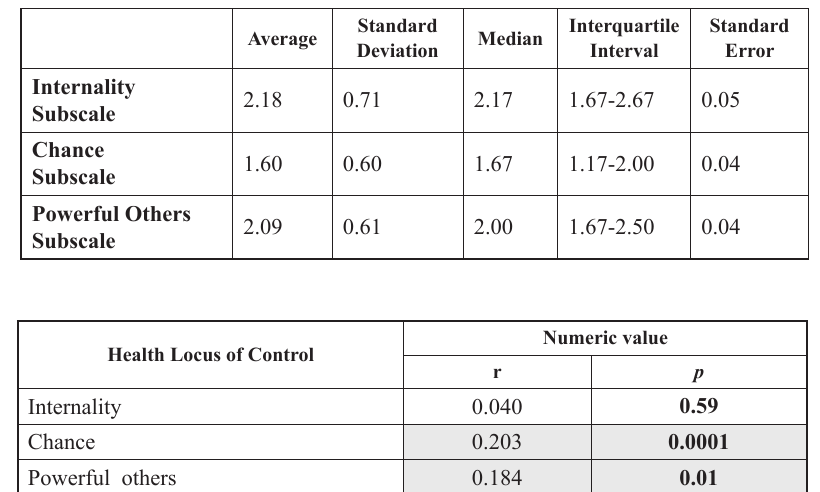
Positive attitude towards remote consultations.